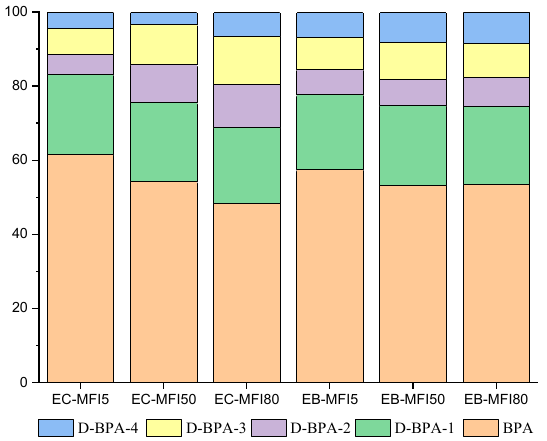
Figure 3. Comparisons of the % of BPA, D-BPA-1, D-BPA-2, D-BPA-3, and D-BPA-4 in Colombia and Brazil.